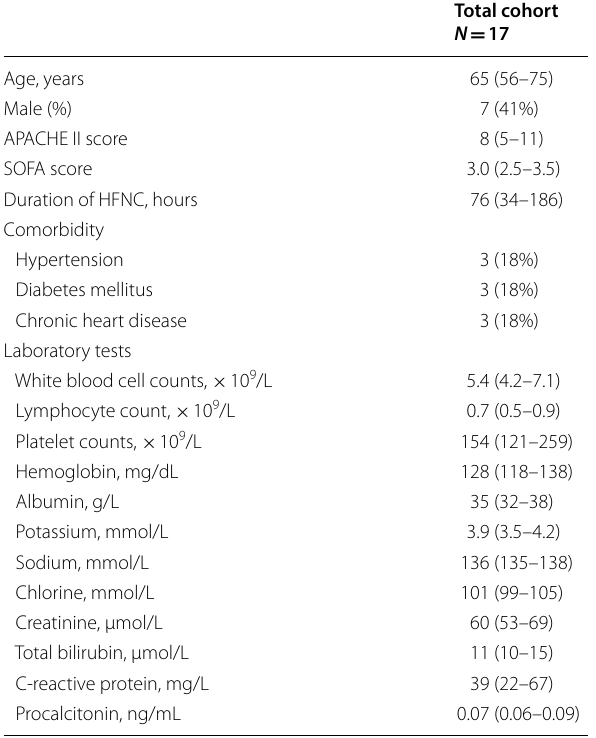
Table 1 Clinical characteristics of the enrolled patients